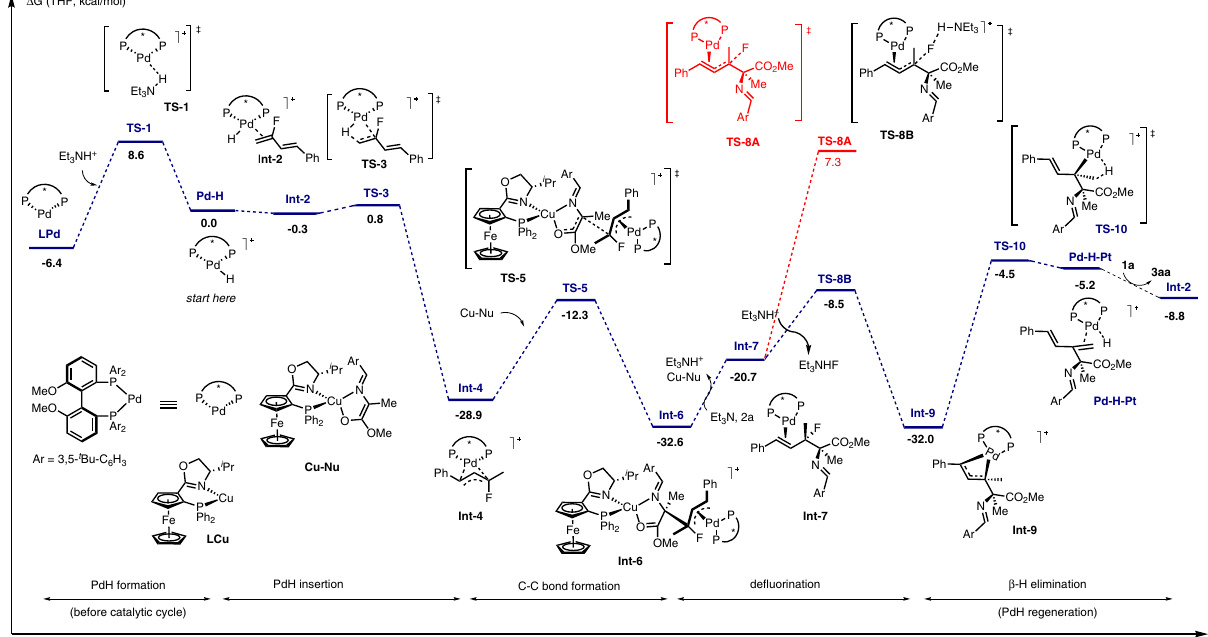
Fig. 8 Energy pro fi le for the proposed mechanism. Calculations were carried out at the M06-2x(SMD)/def2-TZVP//B3LYP-D3BJ/6-31 g(d)/Lanl2dz level of